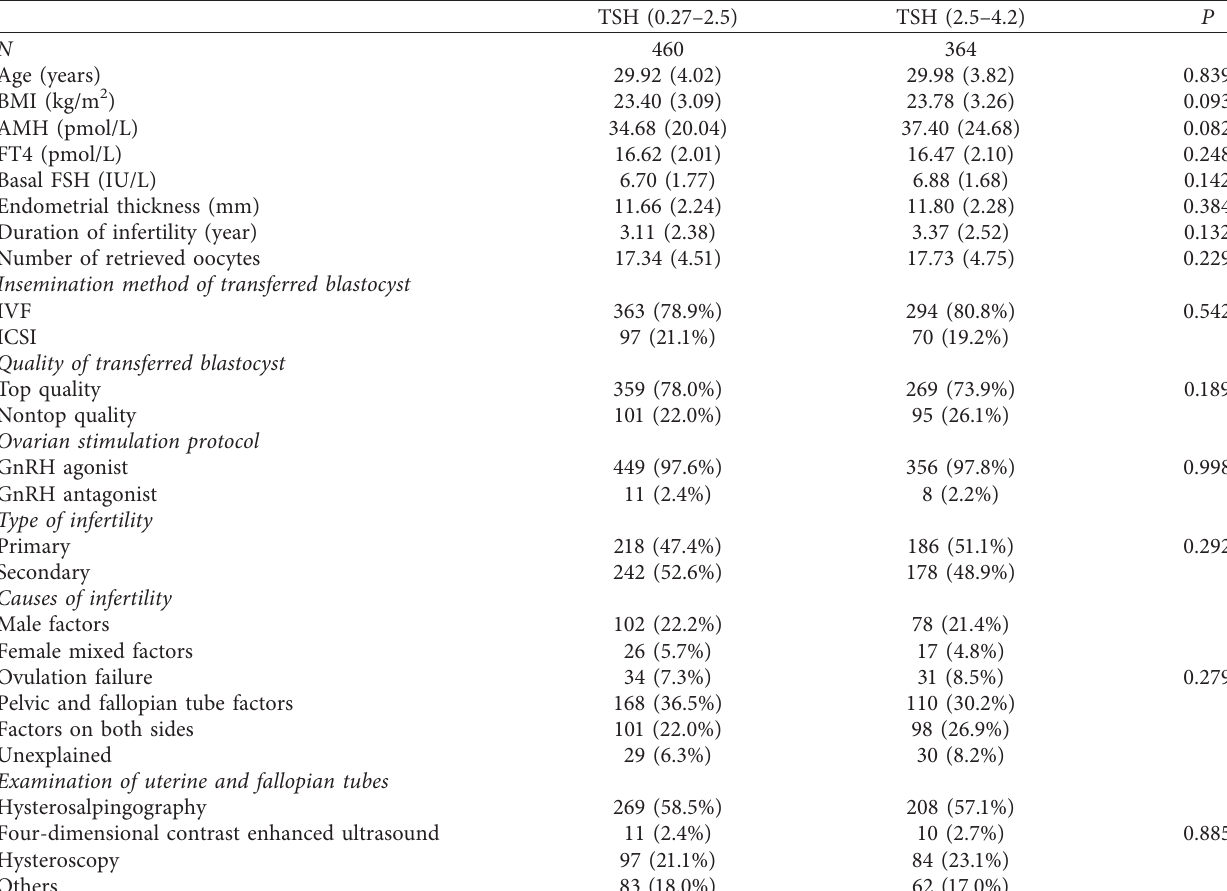
Figure 1: Flow chart of the inclusion of women undergoing the first single blastocyst transfer treatment. Table 1: The general characteristics of the included women based on TSH